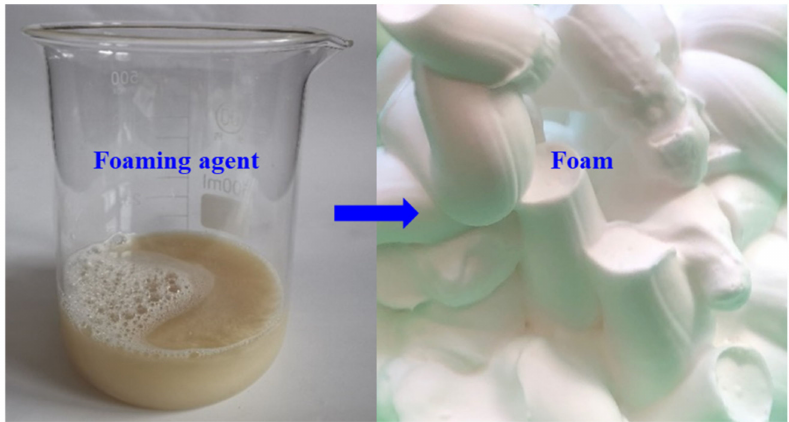
Figure 2. Image of foaming agent and